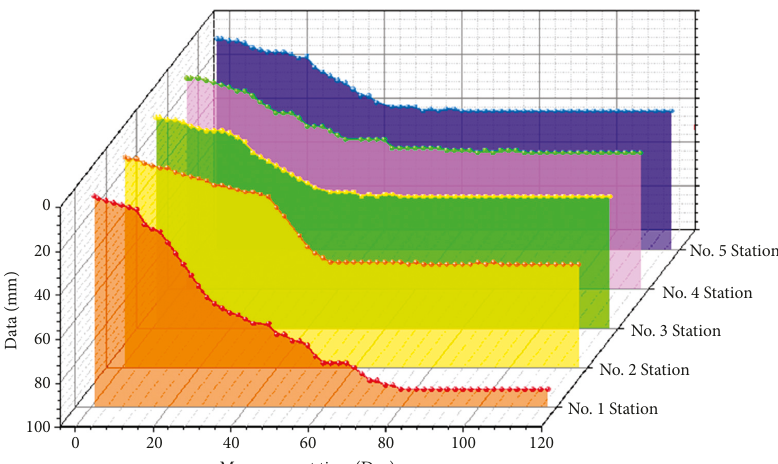
Figure 12: Roadway roof sinking curve.